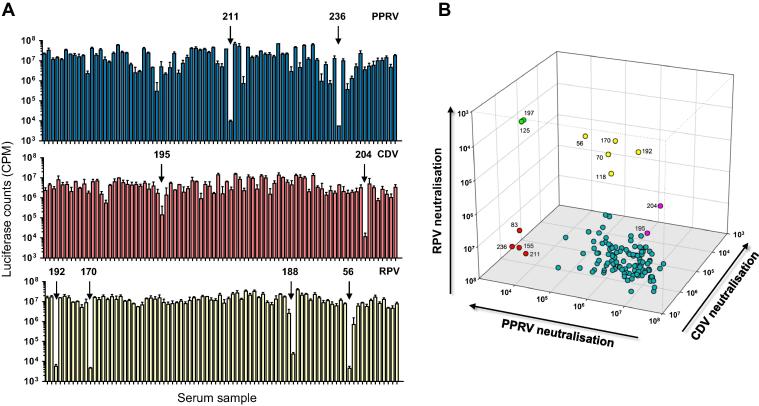
Rapid screening for atypical morbillivirus infections in Tanzanian cattle. Serum samples from 125 cattle collected in the Bunda region of Tanzania were screened for the presence of neutralising antibodies against CDV, PPRV or RPV at a single fixed dilution (1:100). VSV pseudotypes bearing the PPRV (Nigeria/75/1), CDV (Onderstepoort) or RPV (Kabete O) glycoproteins were mixed with each diluted serum sample and plated onto SLAM-expressing target cells. (A) Histograms displaying a 72 subset of samples illustrating clear discrimination of sera with >90% neutralising activity. PPRV (blue), CDV (red) and RPV (yellow). Each point represents luciferase counts per minute (CPM) at 48 h post-infection, mean ± SEM (n = 3). Positive samples are numbered. (B) 3D-plot comparing luciferase activity for PPRV, CDV and RPV for all 125 samples. Neutralising activity was RPV-specific (yellow circles), PPRV-specific (red circles), CDV-specific (pink) or RPV/PPRV cross-neutralising (green). (For interpretation of the references to color in this figure legend, the reader is referred to the web version of this article.)